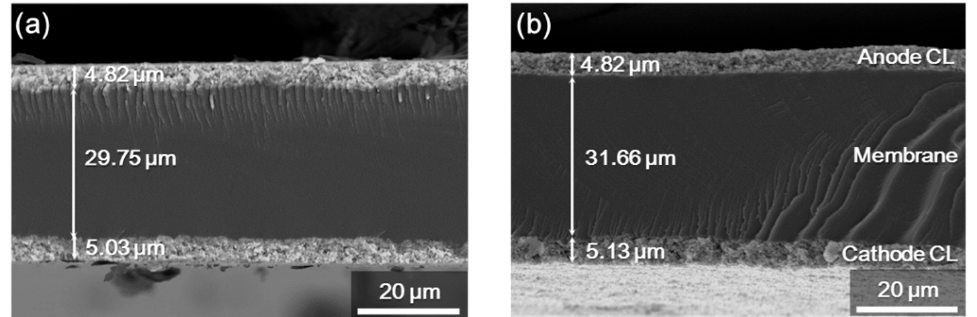
Figure 7. The SEM images showing the cross-section of Hex-SPAES-based MEA: ( a ) in pristine condition; ( b ) after constant-current operation for 350 h.